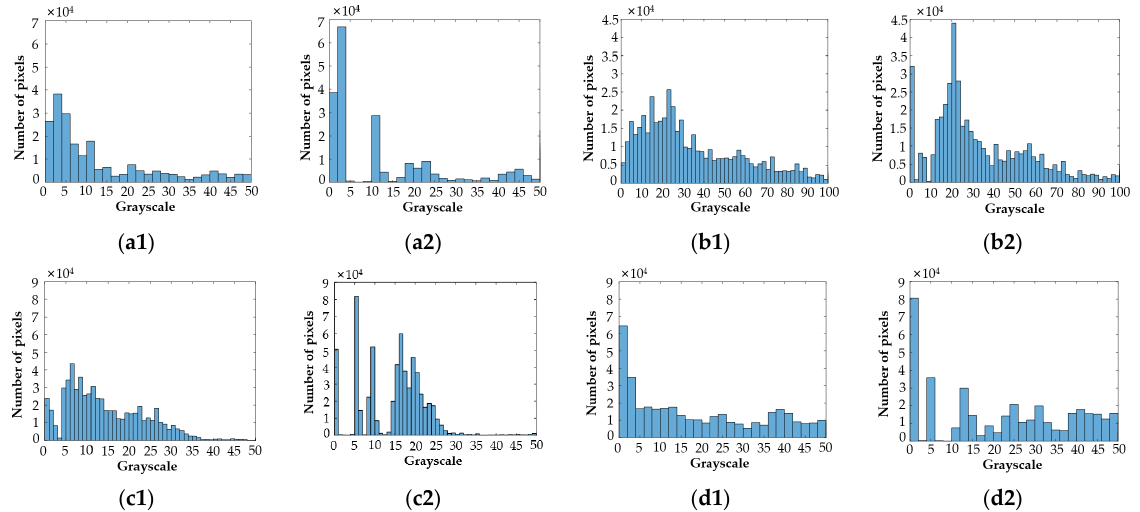
Figure 13. Grayscale histogram comparison before and after overlaying the foreground mask. ( a1 ) Image I before masking, ( a2 ) Image I after masking, ( b1 ) Image II before masking, ( b2 ) Image II after masking, ( c1 ) Image III before masking, ( c2 ) Image III after masking, ( d1 ) Image IV before masking, ( d2 ) Image IV after masking.